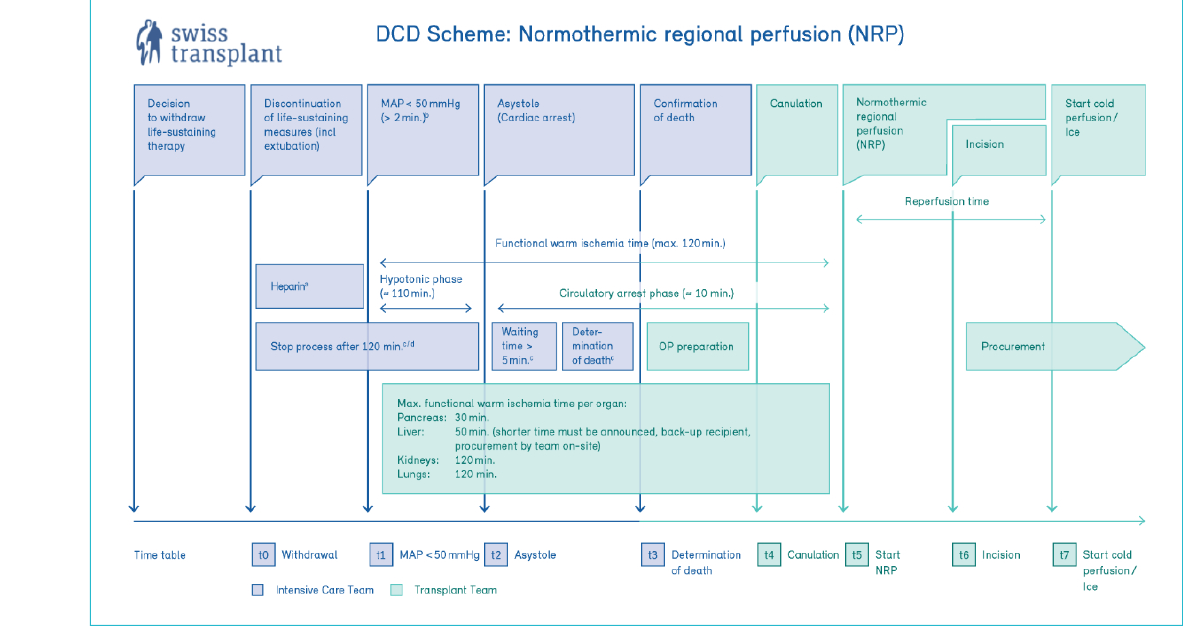
Figure 2: Organ procurement steps and ischaemia times in cDCD when organs are retrieved by the normothermic regional perfusion tech- nique (NRP). Adapted DCD Scheme of the Steering Committee of the National Committee for Organ Donation 2019. a Heparin administration at t0, 300 IU/kg iv. If the likelihood of mortality is low and/or there is an increased risk of bleeding, the attending ICU physician may decide to administer the heparin later but no later than at t1. b The following mean arterial pressure (MAP) values are to be used, depending on age